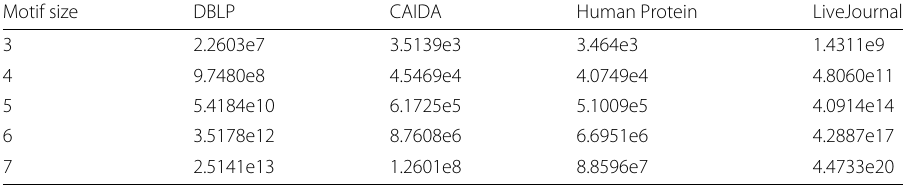
Table 3 Expected number of occurrences for induced counts of all topologies with 3-7 nodes Motif size